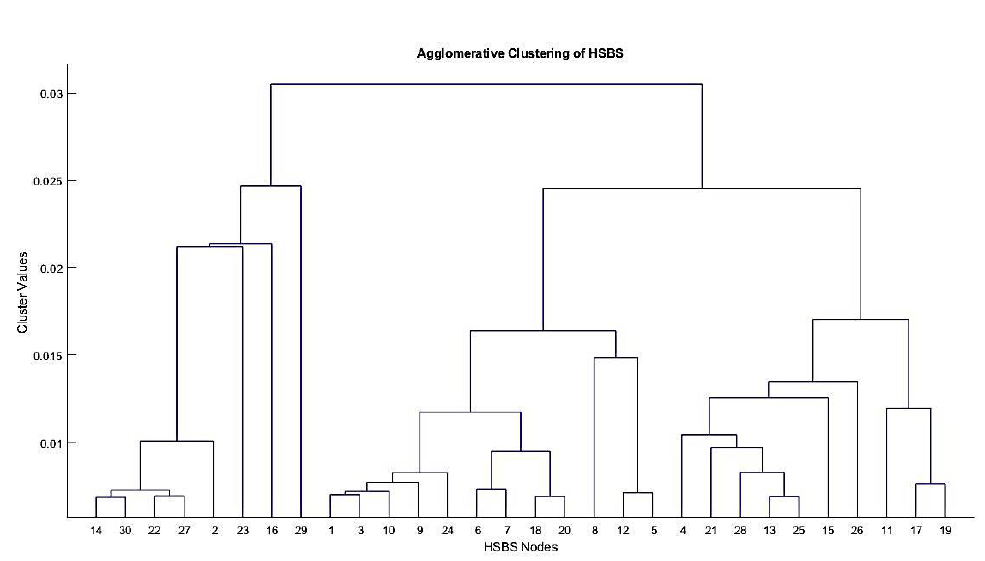
Figure 5. A dendrogram of the HSBS centrally controlled clusters.